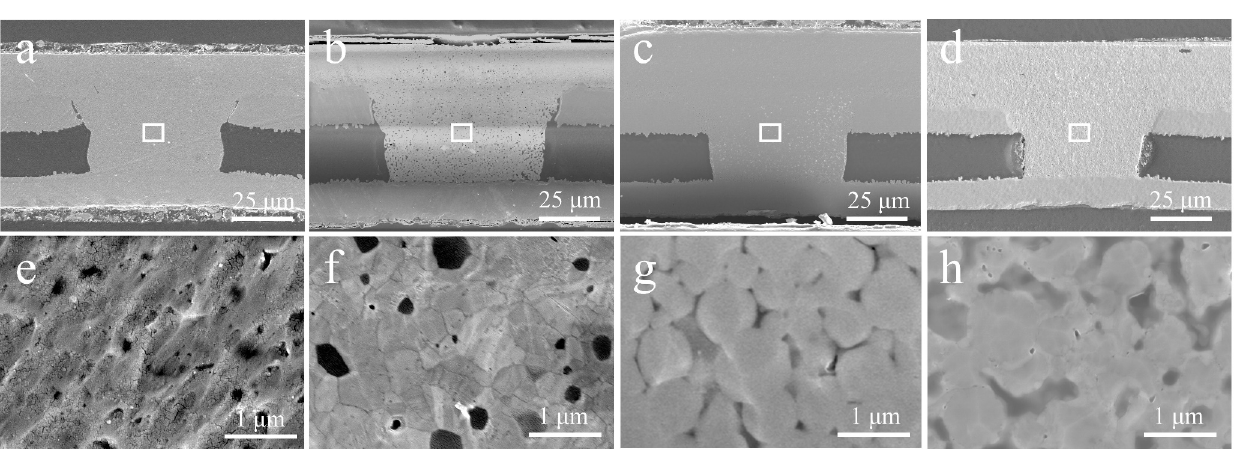
Figure 9. Cross-section images of the microvias filled with ( a , e ) Cu NPs, ( b , f ) Ag NPs, ( c , g ) Cu NMPs, ( d , h ) Cu@Ag NMPs at the sintering temperatures of 260 °C.